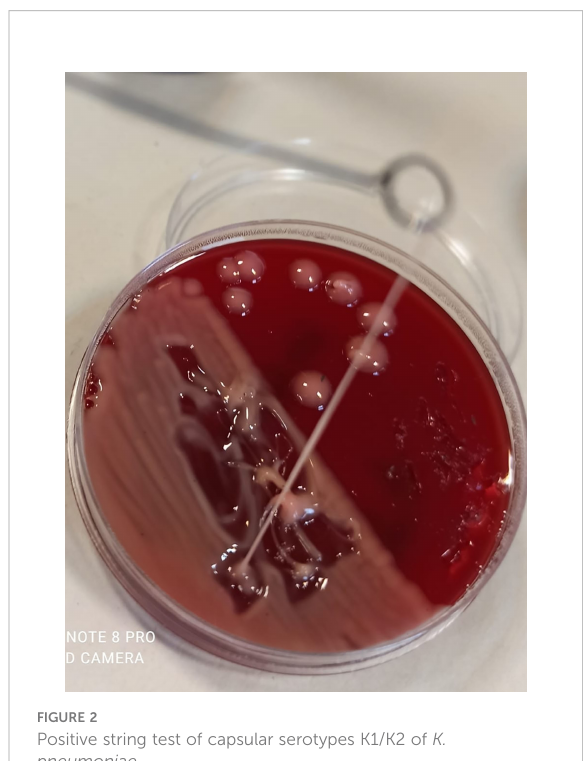
FIGURE 2 Positive string test of capsular serotypes K1/K2 of K.